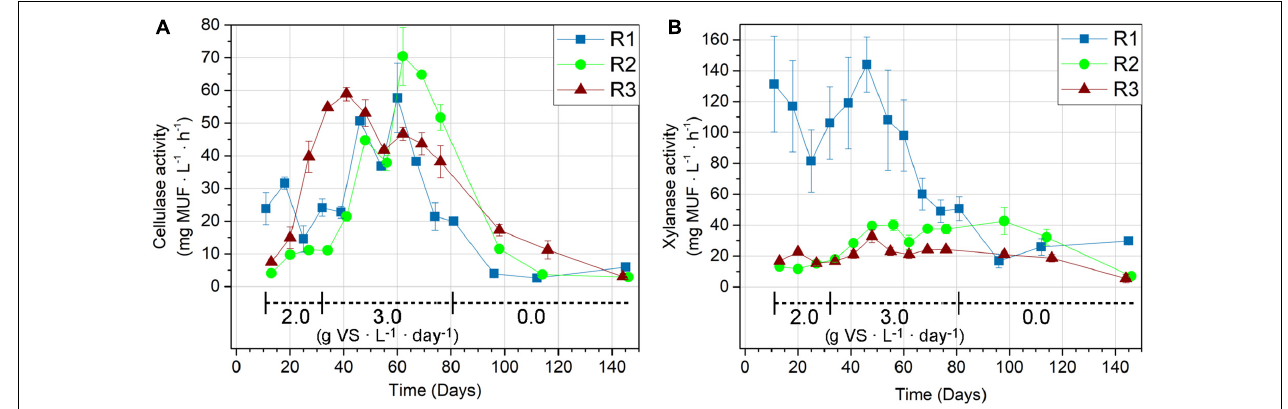
FIGURE 2 | Cellulase (A) and xylanase (B) activities given by MUF release rate in the thermophilic R1, and the mesophilic reactors R2 and R3. The reactors were fed with wheat straw from day 11–81 and organic loading rates (g VS · L − 1 · day − 1 ) are indicated on the